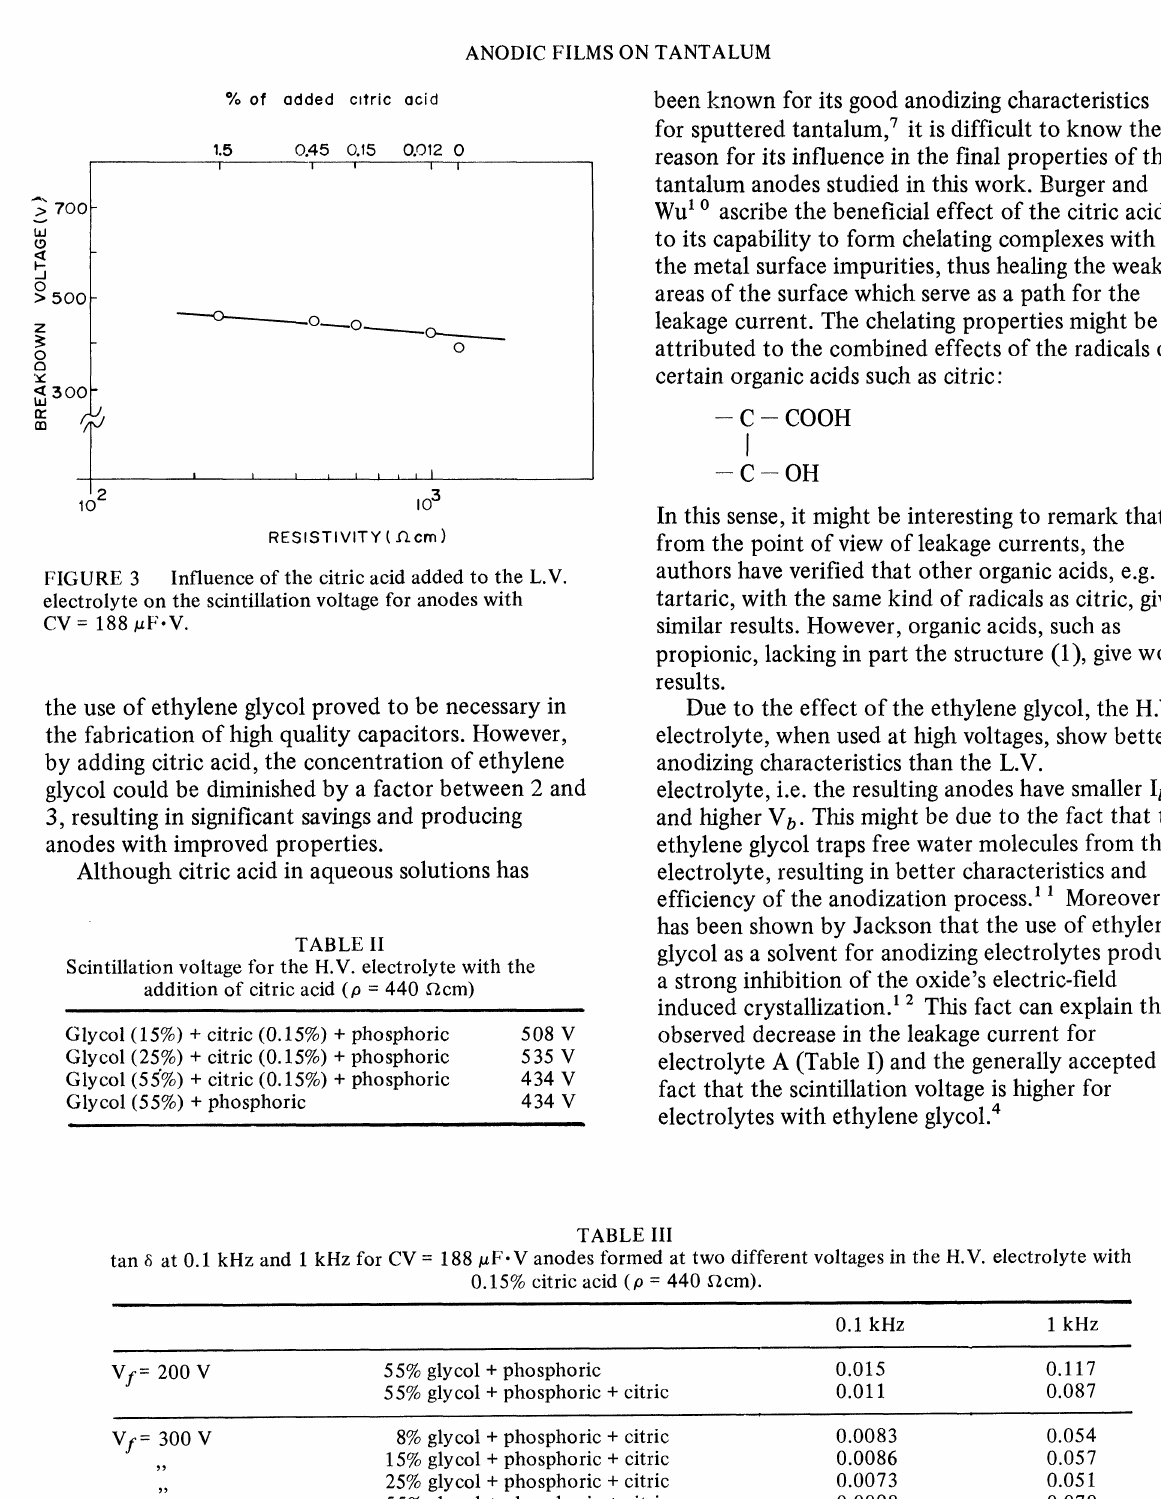
tan 6 at 0.1 kHz and kHz for CV 188 F.V anodes formed at two different voltages in the H.V. electrolyte with 0.15% citric acid (0 440